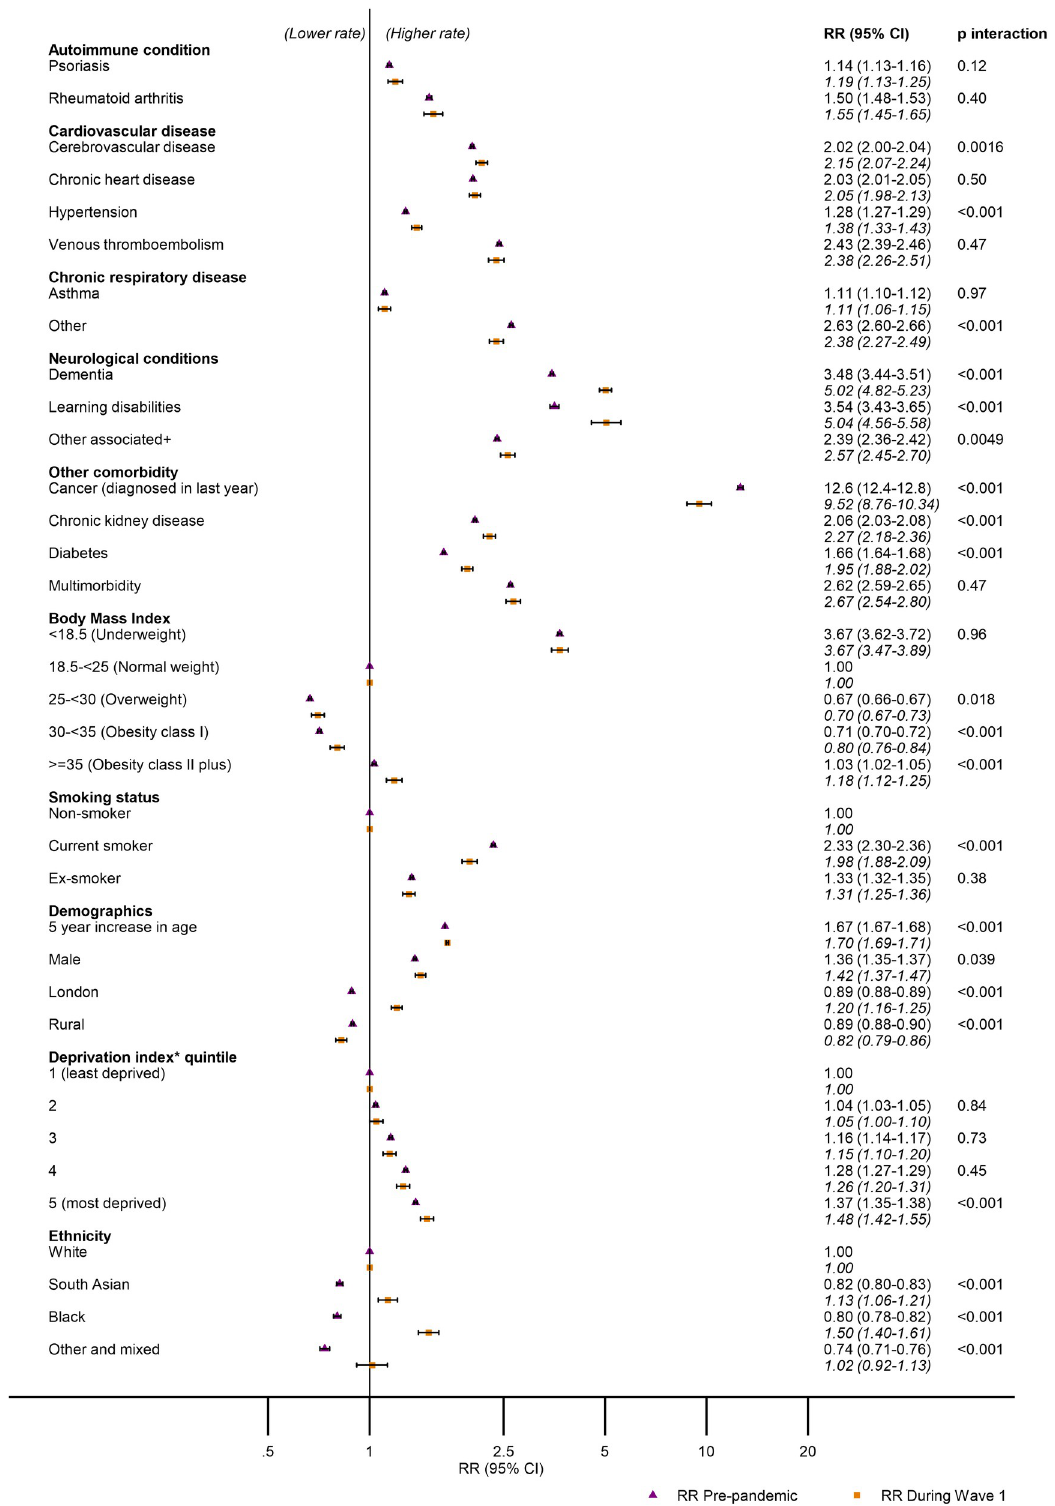
Fig 3. All cause RRs of death and 95% confidence intervals by morbidities, health, and demographic factors prepandemic and during Wave 1 adjusted for age, sex, season, and year. RR, relative rate. +with respiratory infections, � Carstairs Index (not available in Northern